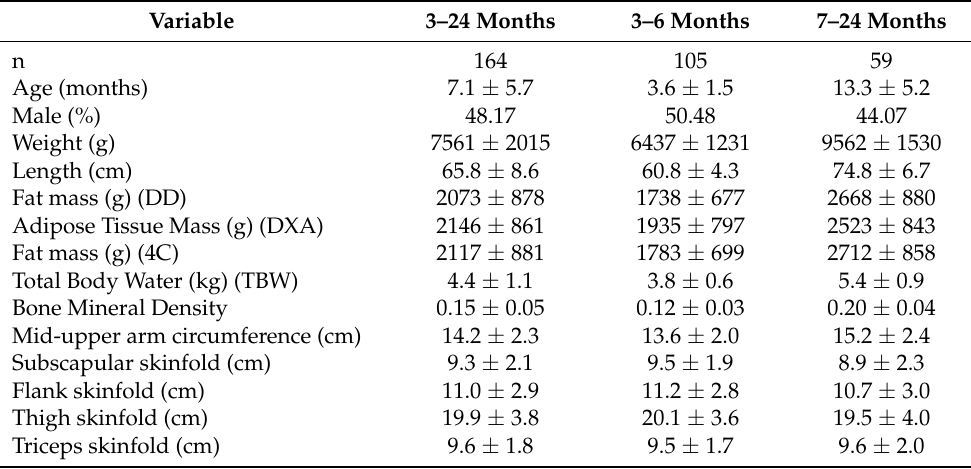
Table 1. Of enrolled infants aged 3–24 months, 416 (63.9%) had available DXA measurements. Of these, 370 (88.9%) had complete NIR and anthropometric measurements. Of these, 164 (25.66%) had acceptable deuterium dilution measurements.